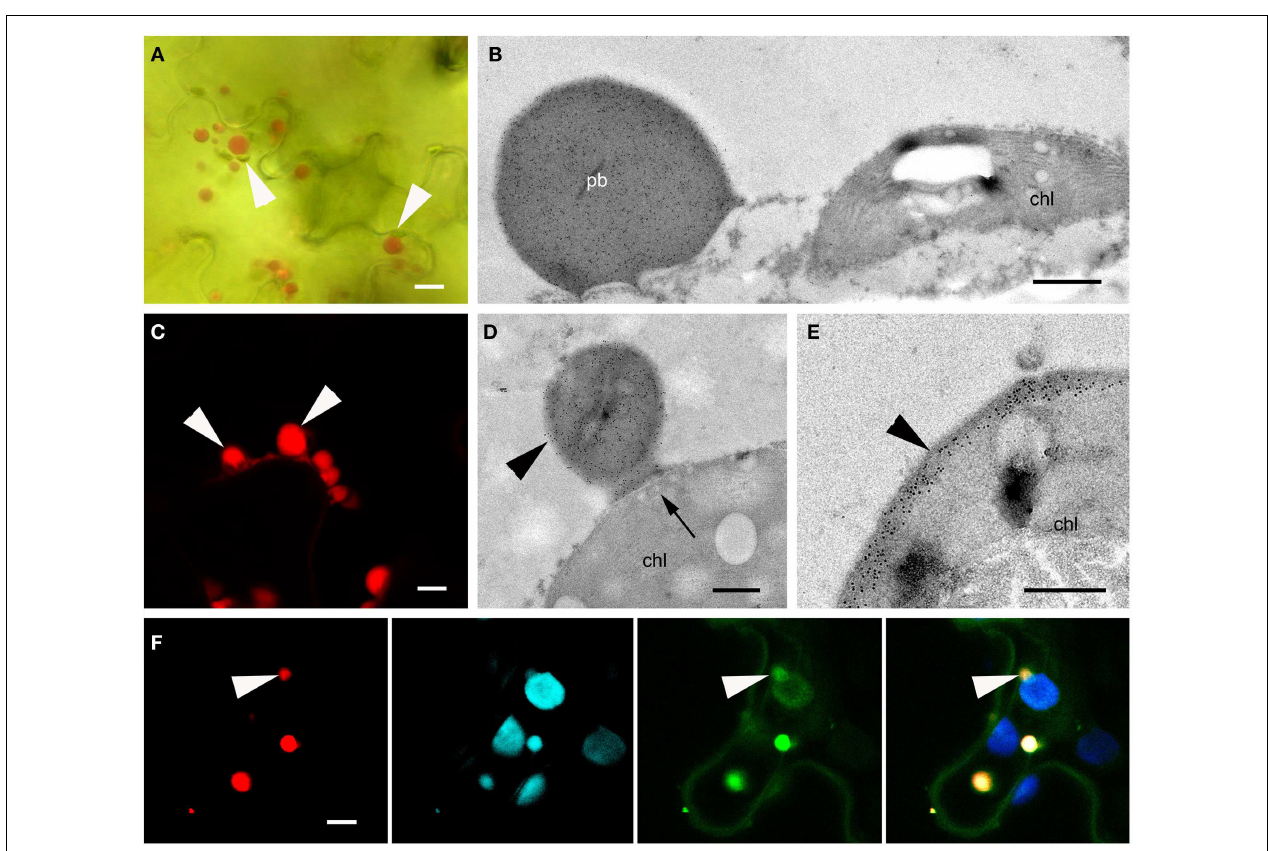
[ (D) , arrowhead, chl], showing tubular thylakoids close to the budding site [ (D) , arrow]. Abundant gold probes in the periphery of the plastid [ (E) , arrowhead]. (F) CLSM image of red fluorescent protein bodies enclosed by the outer plastid envelope membrane highlighted with aTOC-GFP membrane marker (arrowheads). DsRed (far left), plastid autofluorescence (middle-left), GFP (middle-right), and merged channels (far right) are shown. Bars = 10 µ m (A) , 0.5 µ m (B,D–F) , or 5 µ m (C)